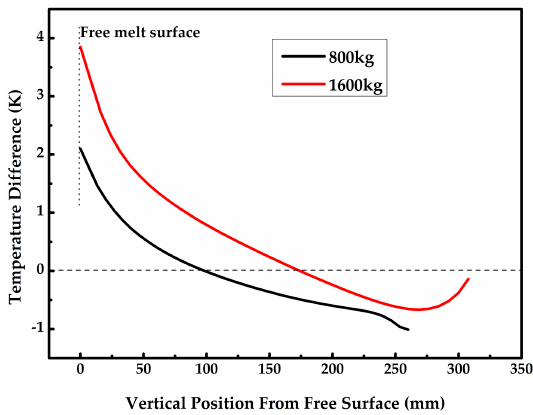
Figure 2. Comparison of temperature differences between the crucible side wall and the central region of the melt at a solidification fraction of 10%.